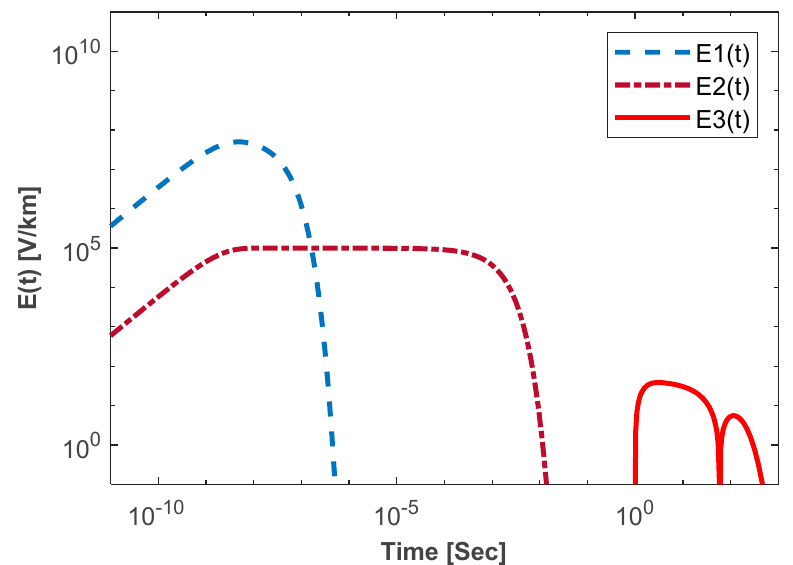
Figure 1. Three waveforms of the high-altitude electromagnetic pulse (HEMP) electric field from International Electrotechnical Commission (IEC) 61000-2-9 [3]. This figure was modified based on reference [3].